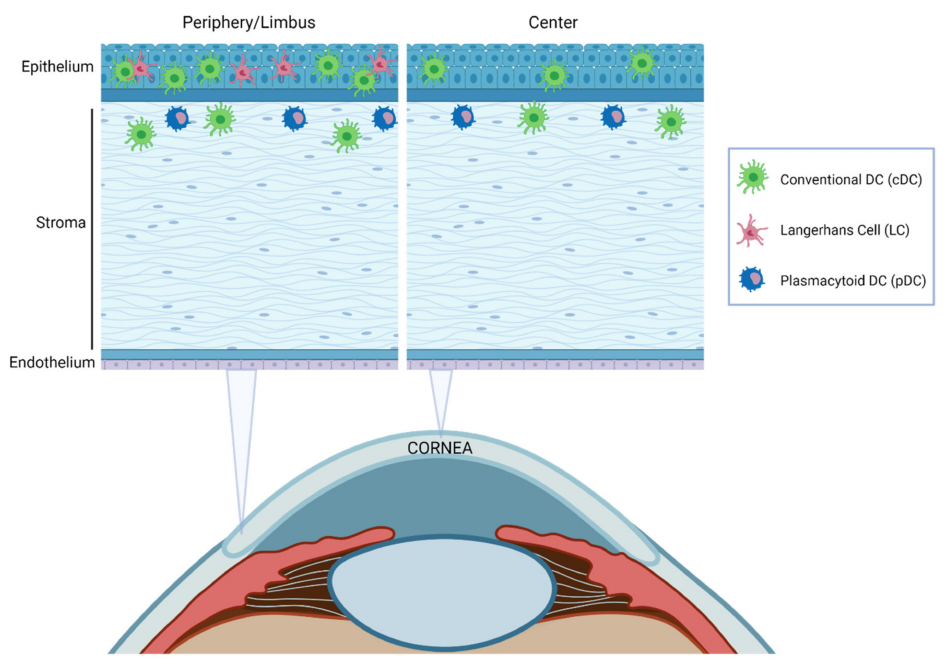
Figure 6. Schematic illustration of the distribution of resident DCs in the cornea at steady-state. Most DC subtypes are preferentially distributed in the epithelium and the anterior stroma and are more abundant in the peripheral cornea and limbal area than in the central